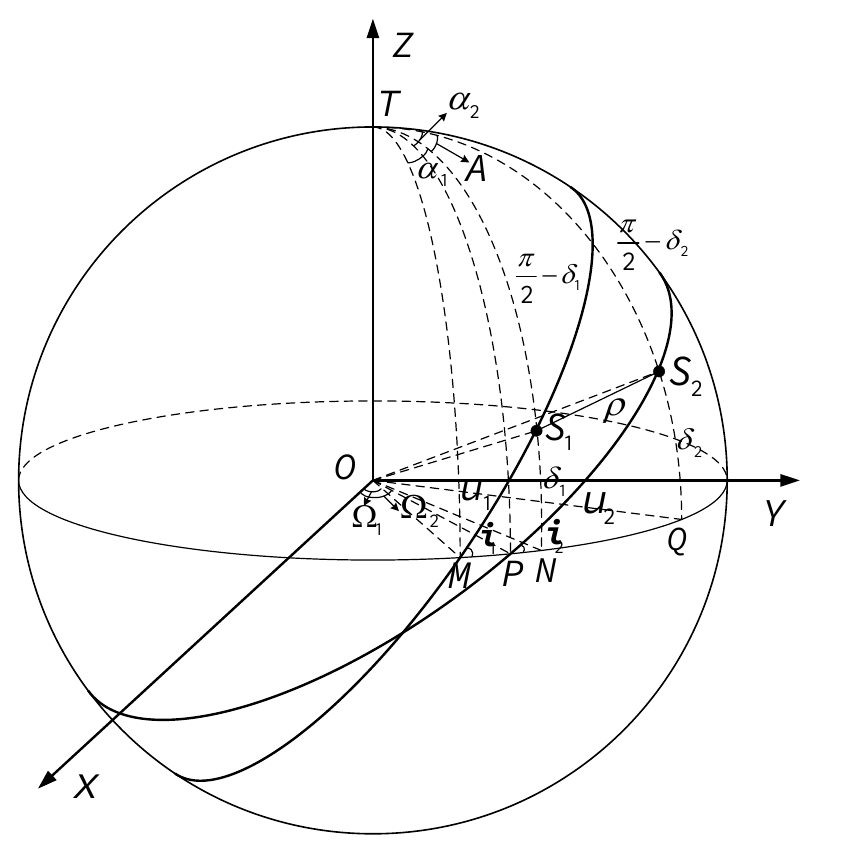
Figure 3. Schematic diagram of the spatial geometry of any two satellites in the ECI coordinate system.